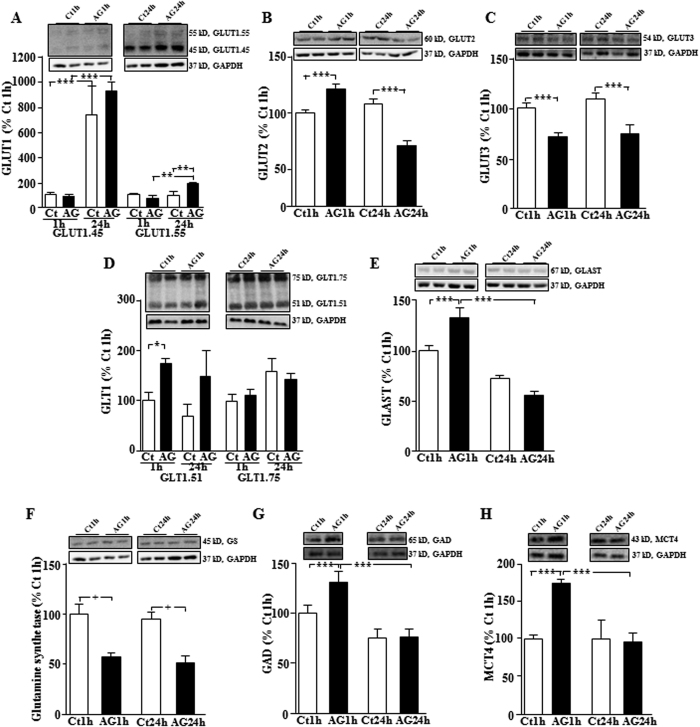
Modulation of glucose and glutamate transporters by acyl-ghrelin.Hypothalamic levels of (A) glucose transporter (GLUT)1, (B) GLUT2, (C) GLUT3, (D) glial glutamate transporter 1 (GLT1), (E) glutamate-aspartate transporter (GLAST), (F) glutamine synthetase, (G) glutamic acid decarboxylase (GAD), and monocarboxylate transporter (MCT)4 at 1 and at 24 hours (h) after icv injection of acyl-ghrelin (AG, 2 μg). *p < 0.05, +p < 0.005, **p < 0.001, ***p < 0.0001. Representative Western blots are from the same gel although samples were not contiguous within the gel.